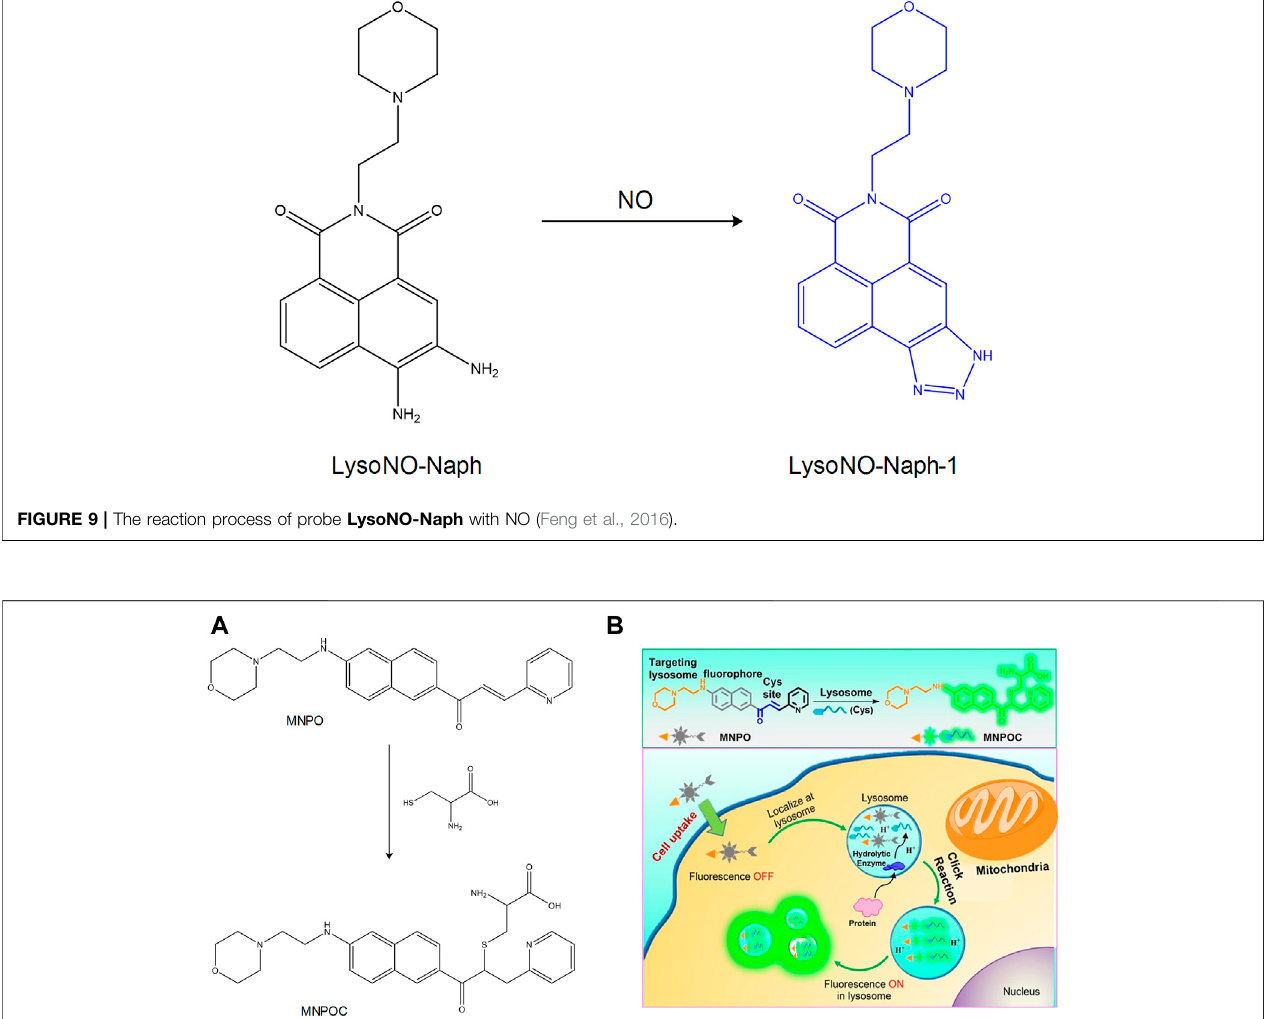
FIGURE 10 | The action mechanism of MNPO with Cys in lysosomes (Long et al., 2019). (A) Proposed response mechanism of MNPO to Cys. (B) Schematic showing the general design of lysosome-targeting fl uorogenic probe MNPO for Cys.